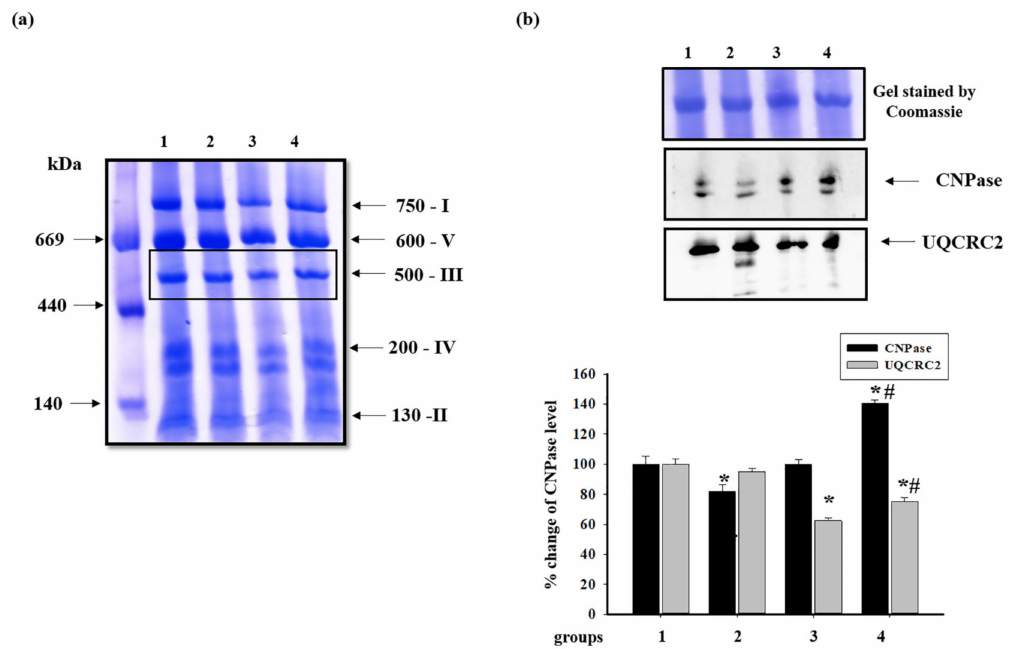
Figure 8. E ff ect of AST and ISO on the level of proteins associated with complex III (CIII) in rat heart mitochondria. ( a ) Freshly prepared rat mitochondria isolated from each group were solubilized in the bu ff er for BNE samples (Materials and Methods Section). Mitochondrial samples were separated by 1D BNE, and excised bands were subjected to 2D SDS-PAGE; ( b ) the upper part: Western blot stained with monoclonal antibodies against UQCRC2 (cytochrome b-c1 complex subunit 2) and CNPase; the lower part: a diagram quantitatively reflecting changes in protein levels. The data are presented as the means ± SDs of four independent experiments. * p < 0.05—a significant di ff erence in the protein level compared with the control (group 1), # p < 0.05 compared to RHM from rats injected with ISO (group 3). The statistical significance of the di ff erences between the pairs of mean values was evaluated